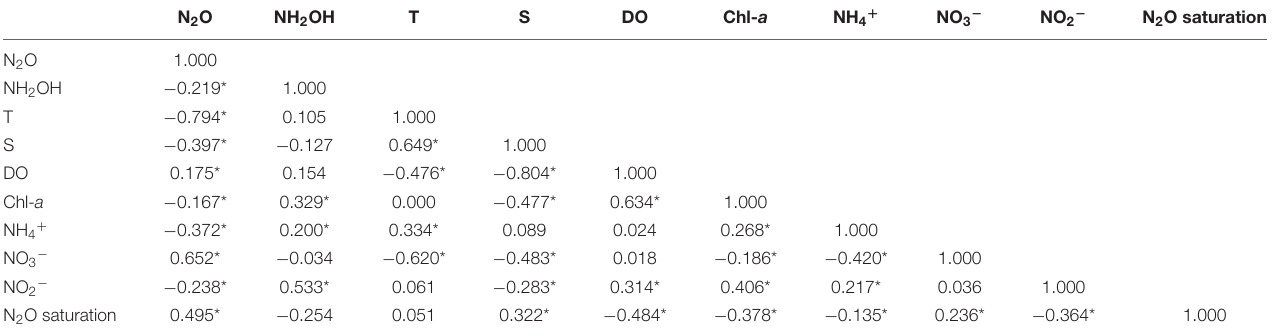
TABLE 1 | Spearman correlation coefficient matrix for biogeochemical parameters measured in the SYS and the ECS. N 2 O